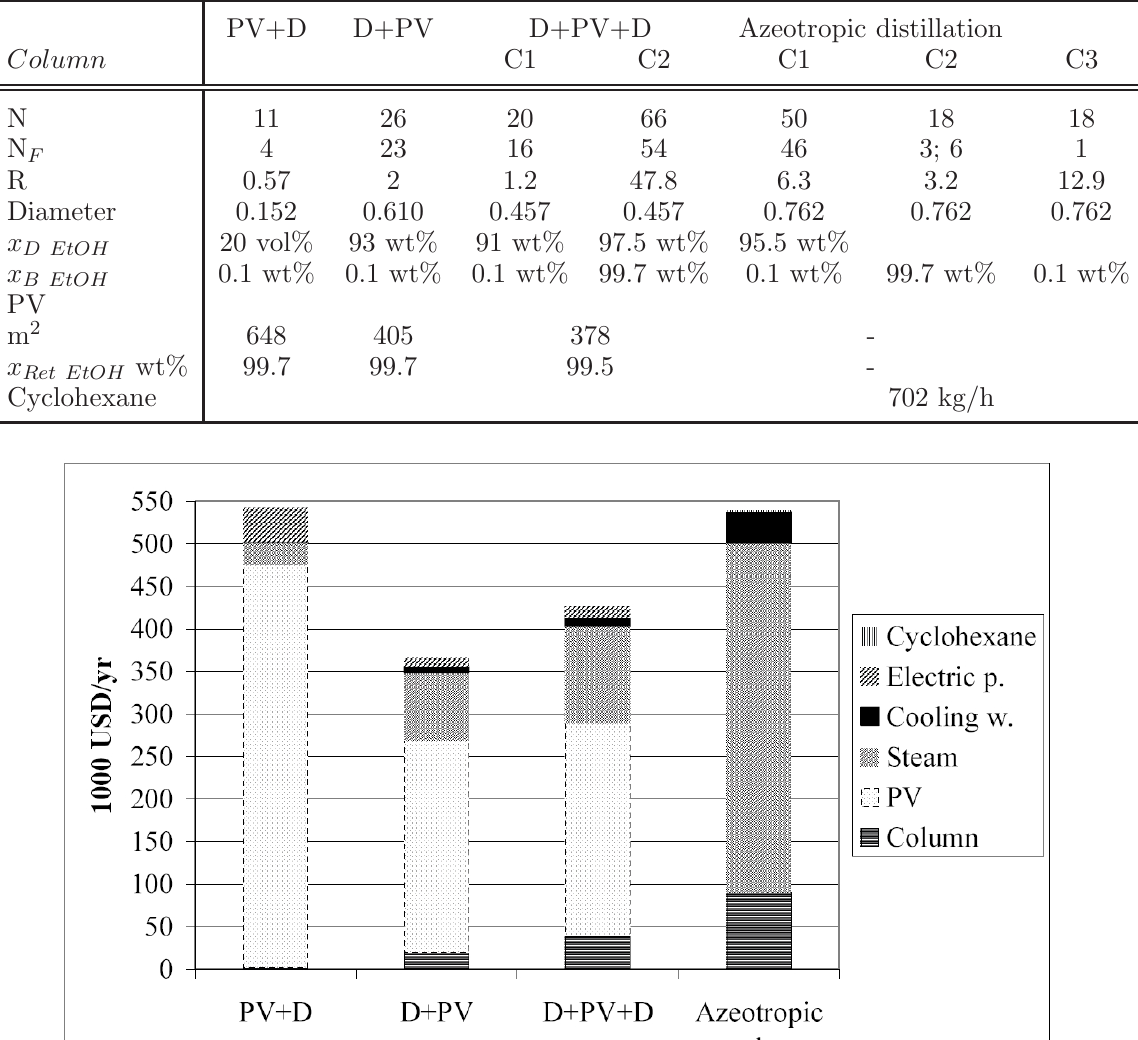
Table 11 Optimal parameters of adiabatic pervaporation.